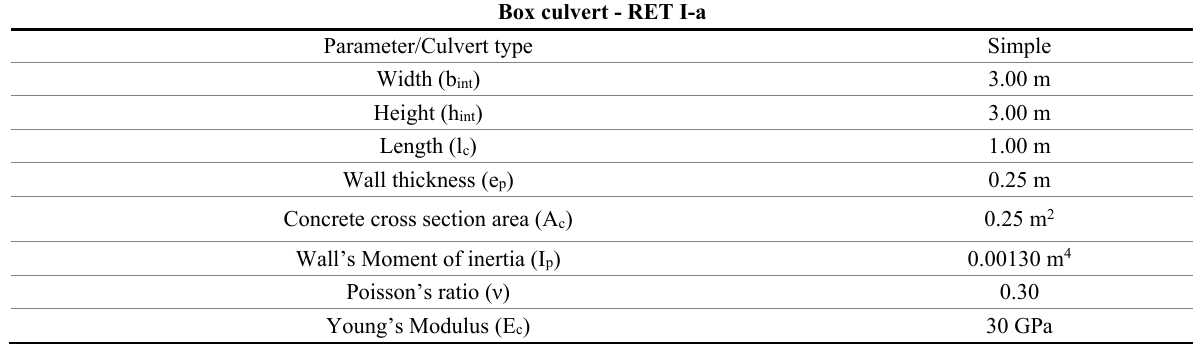
Table 3. Geometric parameters of the reference box cul vert.